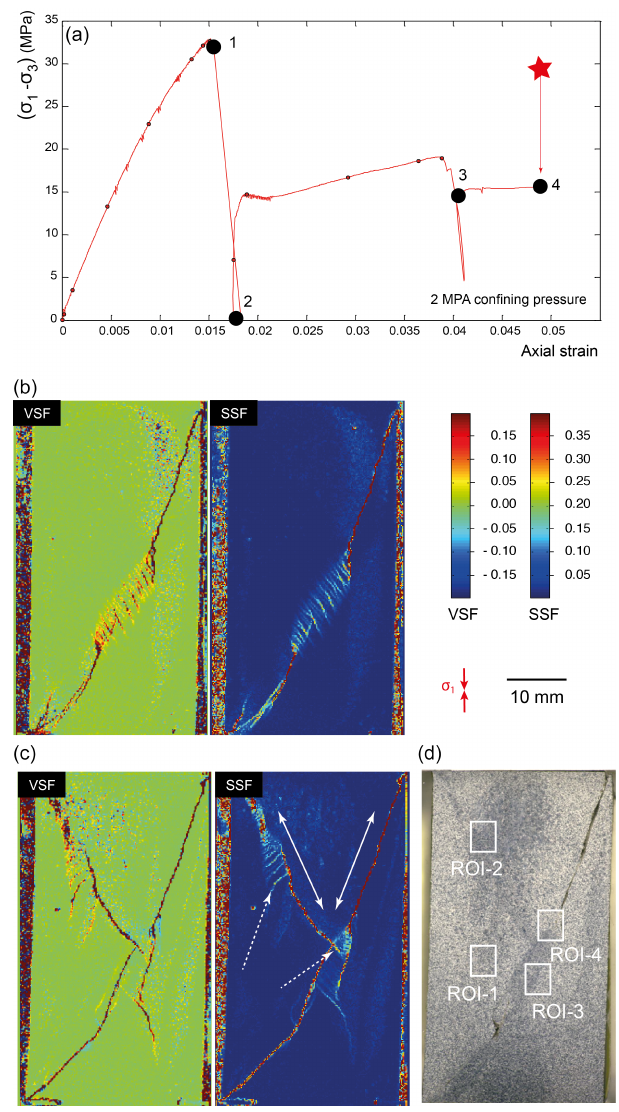
Figure 2. Results of deformation test done on sample COX-2MPa. (a) Deviator stress vs. axial strain response. The red star indicates the state of the sample when BIB–SEM microstructural analyses are done. (b, c) Incremental volumetric strain fields (VSF) and maximum shear strain fields (SSF) for deformation increments 1–2 (b) and 3–4 (c) indicated in (a) after DIC. Arrows with solid lines indicate the set of two conjugated synthetic fractures, whereas the arrows with dashed lines show antithetic fractures oblique to the conjugated fractures. (d) Selection of differently strained areas (re- gion of interest (ROI)) highlighted from DIC analysis for BIB–SEM microstructural analyses. Four ROI were analysed: three at conju- gate synthetic fractures in areas with a different amount of diffuse strain and antithetic fractures (ROI-2, ROI-3 and ROI-4) and one in a region without measurable strain (ROI-1). The bedding is per- pendicular to the mean principal stress σ 1 . Performed according to Bésuelle et al.